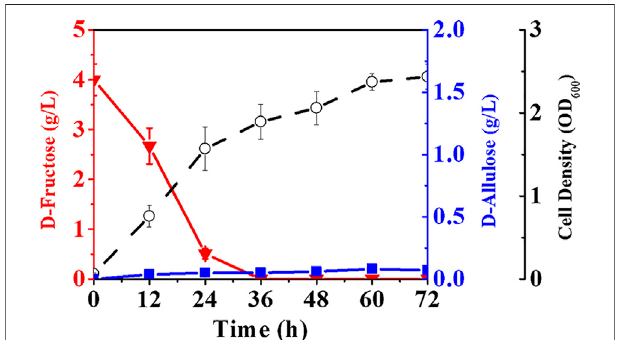
FIGURE 3 | Production of D-allulose by E. coli co-expressing AlsE and A6PP. E.coli ( alsE , a6PP )wasculturedinLBmediumwith4.00 g/LD-fructose at 37 ° C. Error bars, SD , n = 3 .